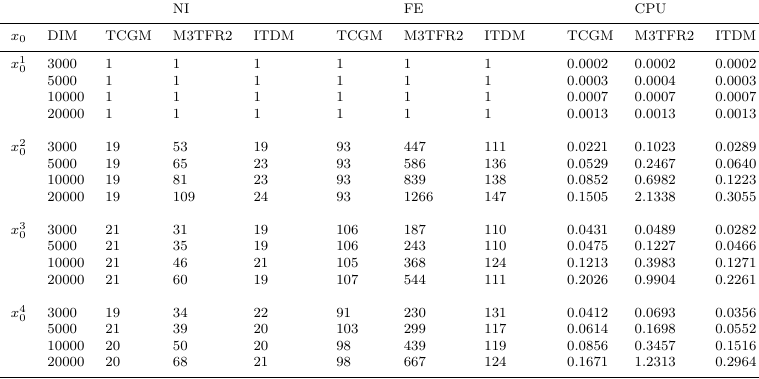
Table 9. Numerical results of Problem